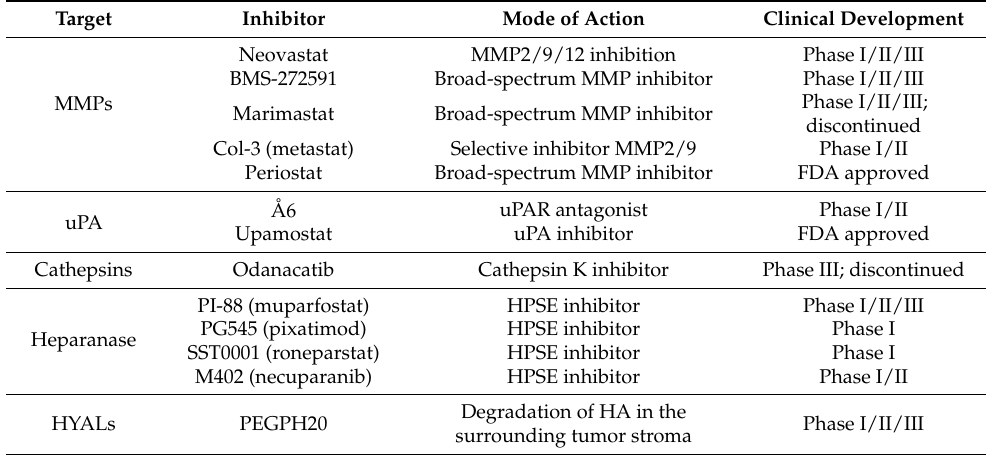
Table 4. Summary of major matrix enzymes as pharmacological targets, their mode of action and clinical